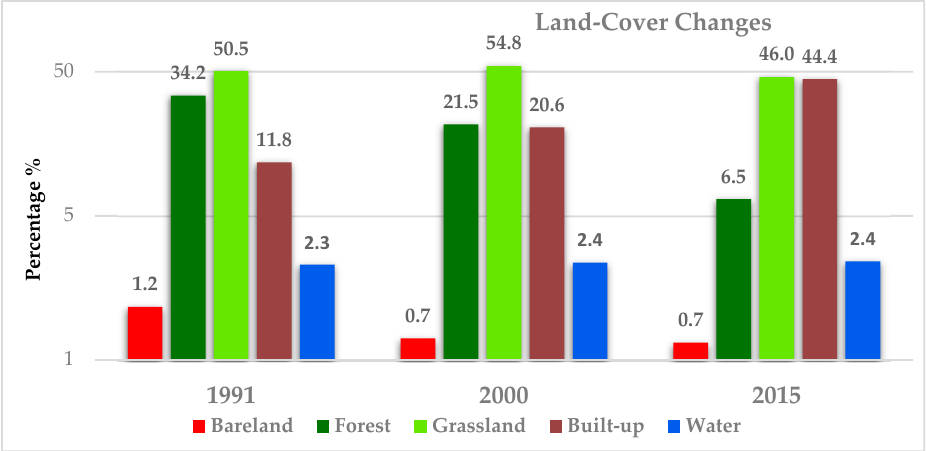
Figure 4. Land-use type percentage coverage for 1991, 2000, and 2015.